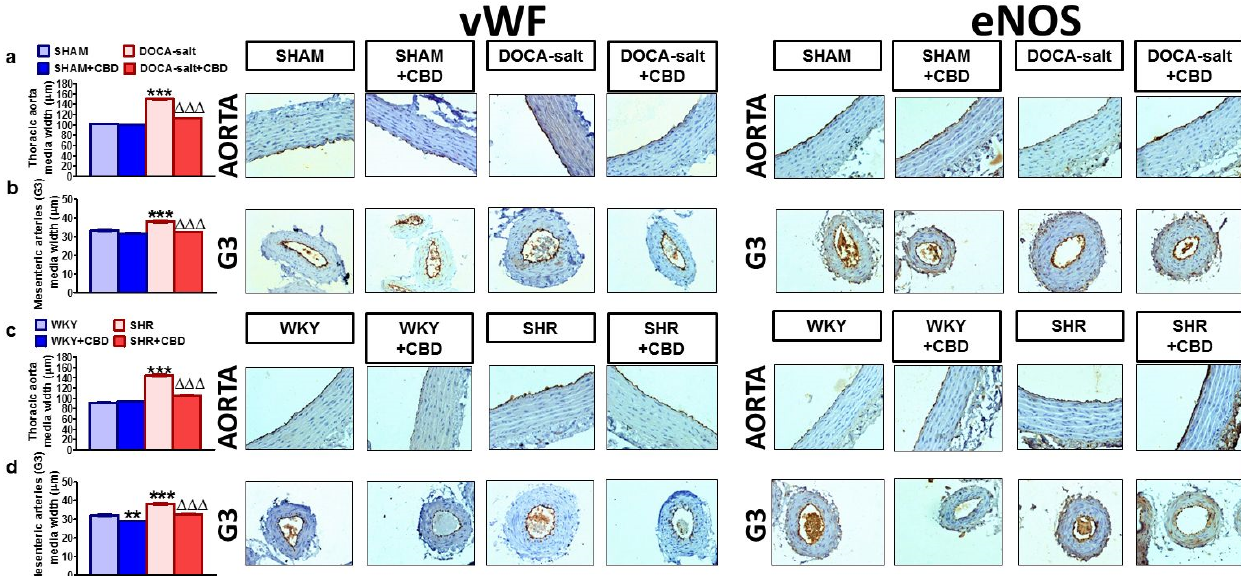
Figure 4. Representative micrographs of the vascular remodeling and influence of cannabidiol (CBD) and its vehicle on immunohistochemical staining of von Willebrand factor (vWF) and endothelial nitric oxide synthase; prostacyclin synthase (eNOS) in cross-sections of the aortic wall and mesenteric G3 arteries isolated from deoxycorticosterone-induced (DOCA- salt) and spontaneously (SHR) hypertensive rats and their normotensive controls, sham-operated (SHAM) and Wistar–Kyoto (WKY) rats, respectively; (magnification 200×). The bar graphs ( a – d ) illustrate the measured aortic and mesenteric G3 artery medial widths. H + E staining. CBD (10 mg/kg) or its vehicle was injected i.p. every 24 h for 14 days. Mean ± SEM of n = 6 tissues for each bar. ** p < 0.01 and *** , ∆∆∆ p < 0.001 compared to the respective control groups (* SHAM/WKY or ∆ DOCA-salt/SHR), as determined by one-way ANOVA followed by Bonferroni’s multiple-comparison tests.